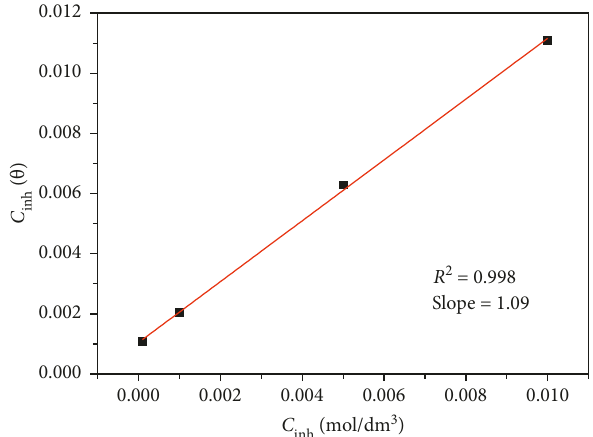
Figure 10: Langmuir adsorption isotherm of cysteine on the brass